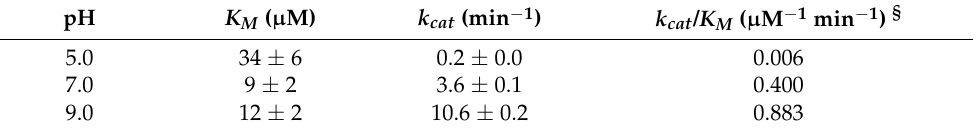
Table 2. Michaelis–Menten kinetic parameters of the pyrophosphatase activity of r Eh